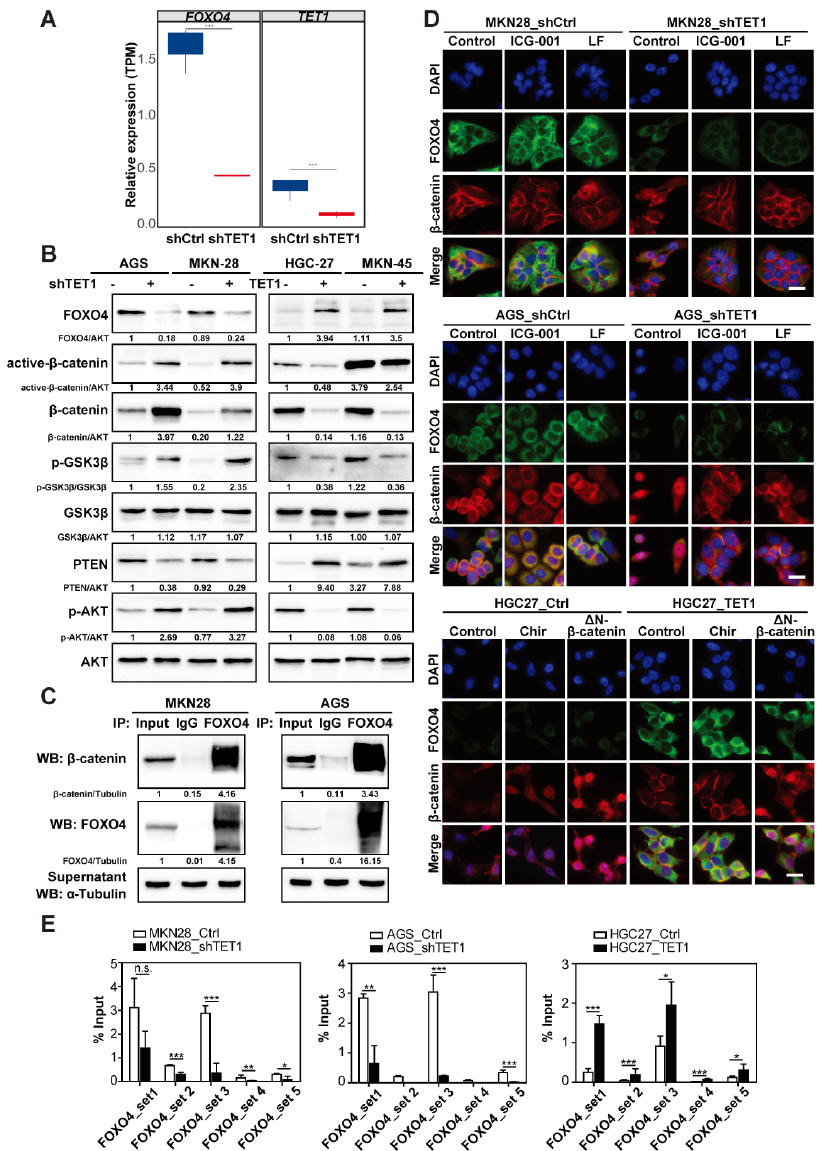
Figure 5. TET1 inhibits Wnt signaling through FOXO4 transactivation. ( A ) RNA-seq analysis of AGS stable cell lines (shTET1 vs. shCtrl) showing differentially expressed TET1 and FOXO4 transcripts. ( B ) Immunoblot analysis of indicated proteins in stable gastric cancer cell lines. ( C ) Immunoprecip- itation of MKN28 and AGS cell lysates using anti-FOXO4 antibody, followed by immunoblot anal- ysis of β -catenin and FOXO4. α Tubulin was used as loading control. ( D ) IF staining of FOXO4 and β -catenin of MKN28, AGS and HGC27 stable cell lines with the indicated treatments or transient transfection. Scale bars represent 100 µm. ( E ) ChIP-qPCR analysis using an anti-TET1 antibody and PCR primers specific for FOXO4 promoter in MKN28, AGS, and HGC27 stable cell lines. Error bars indicate mean ± SD. ***, p < 0.001. **, p < 0.01. *, p < 0.05. n.s., not significant.